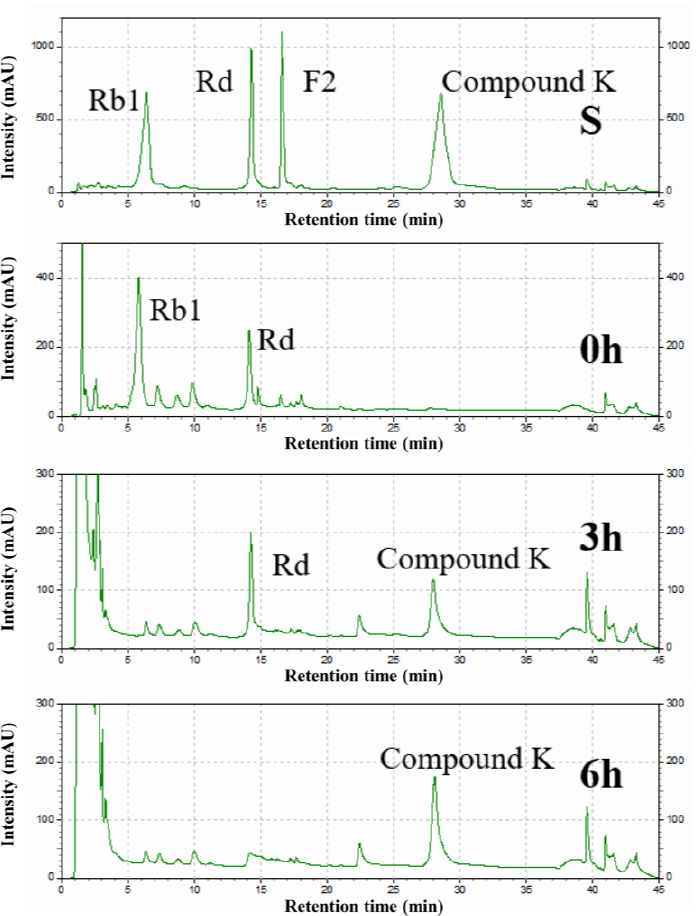
Figure 5. HPLC analysis of the intermediates from ginsenoside substrate into CK by the recombinant SS-bgly.